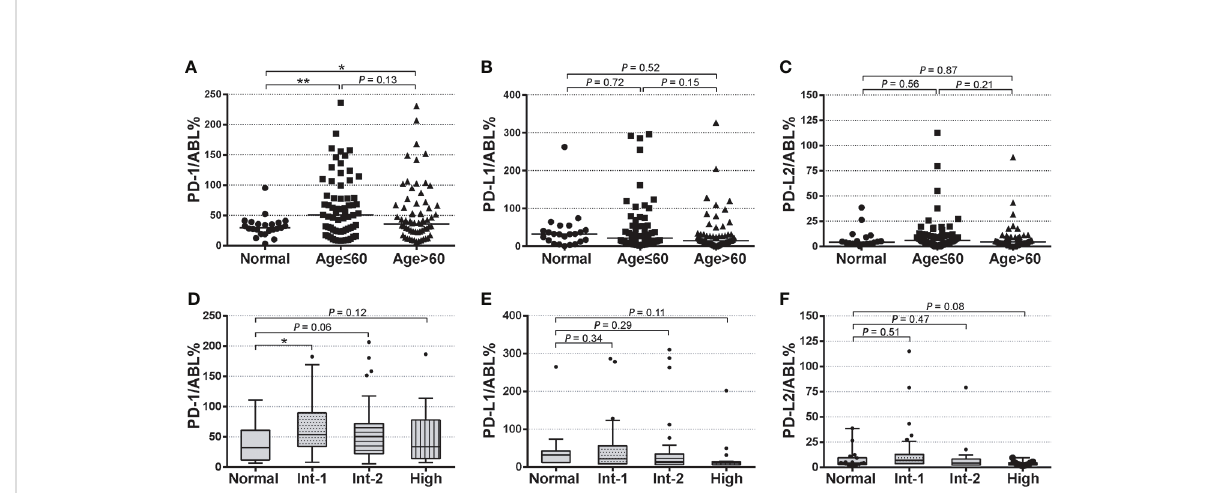
FIGURE 2 Baseline expression of PD-1, PD-L1, and PD-L2 in age-based and risk-based MDS subgroups (A – C) Normalized baseline expression levels of PD-1, PD-L1, and PD-L2 in healthy individuals, young MDS (age ≤ 60 years), and older MDS (age>60 years). (D – F) Normalized baseline expression levels of PD-1, PD-L1, and PD-L2 in healthy individuals and patients with intermediate-1, intermediate-2, and high-risk strati fi cation. Results were presented as mean ± SEM of independent cases. *P < 0.05. ***P < 0.001.